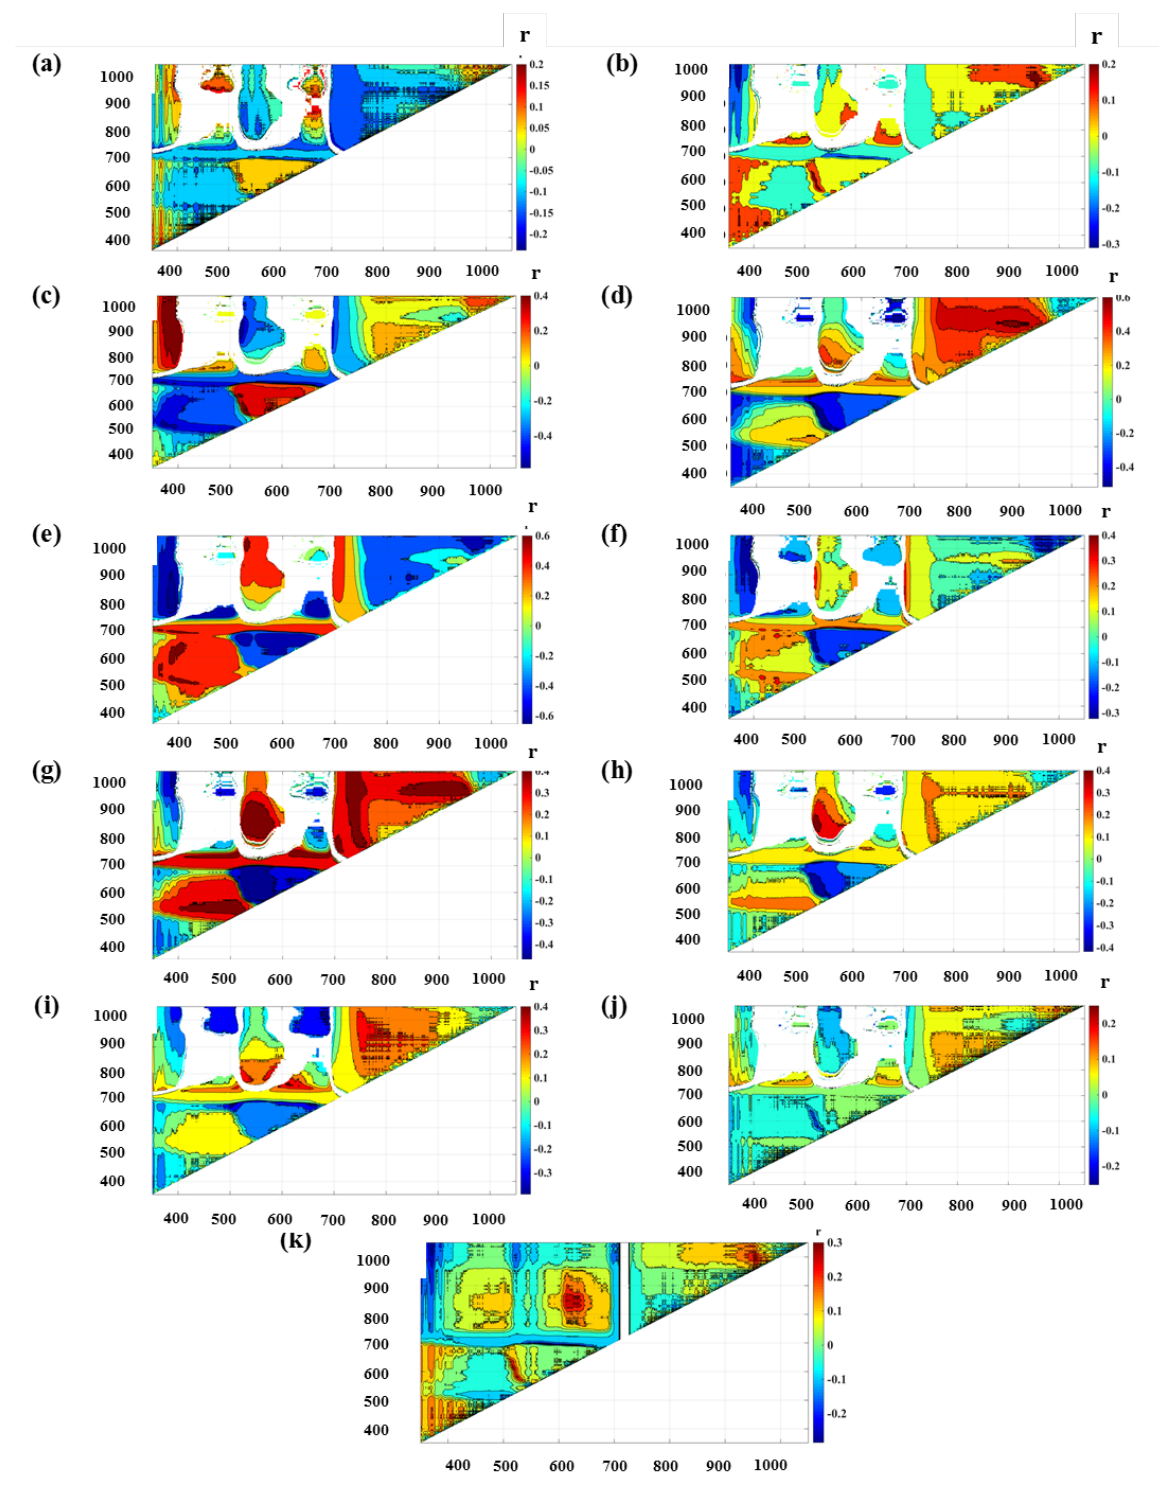
Figure 4. Contour plots for the linear relationship of normalized difference spectral indices with ( a ) N, ( b ) P, ( c ) K, ( d ) Ca, ( e ) Mg, ( f ) S, ( g ) Fe, ( h ) Mn, ( i ) Zn, ( j ) Cu, and ( k ) B. (Both x and y-axis represent wavelength in nm, and r is the correlation coefficient).